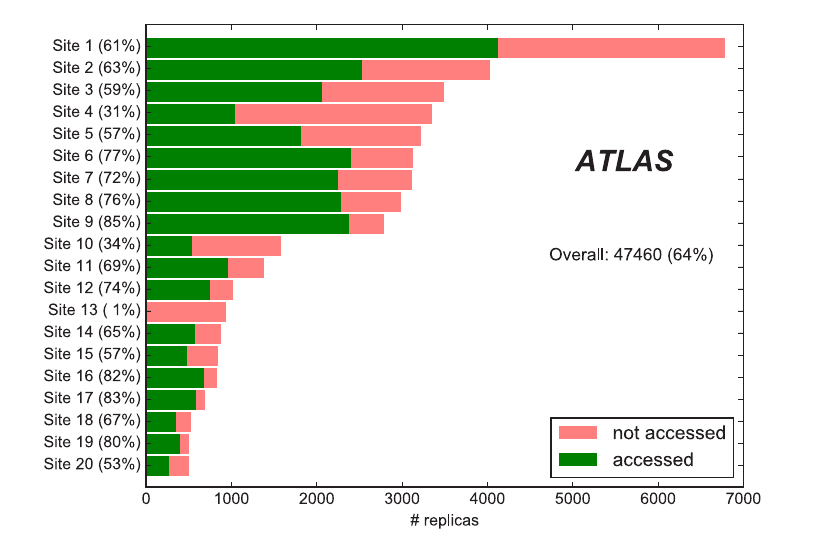
Figure 1. Number of accessed and not accessed replicas according to the leading 20 sites at which they were